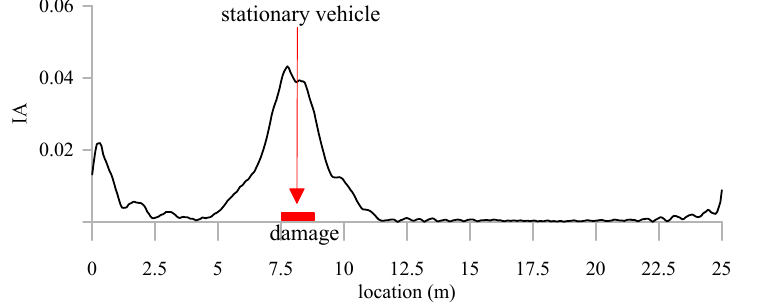
Figure 7. IA of the contact-point response of a stationary vehicle parked at the location of the damage.